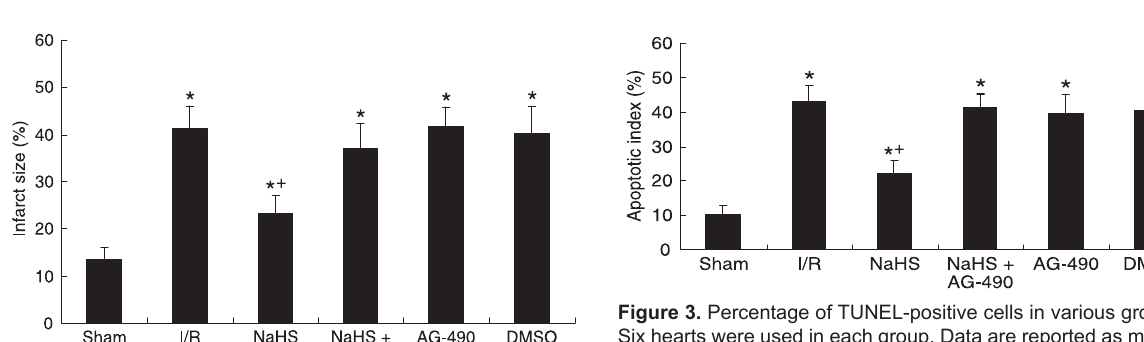
Figure 4. Western blot analysis. The phosphorylation status of STAT3 (86 kDa) ( A ), bcl-2 (26 kDa) and bax (21 kDa) ( B ) was analyzed by Western blot with specific phospho-STAT3 (Tyr705), bcl-2 and bax antibodies at the end of reperfusion. Four hearts were used in each group. Data are reported as means ± SD. *P < 0.05 vs Sham; + P < 0.05 vs I/R; ‡ P < 0.05 vs NaHS (one- way ANOVA). For abbreviations of groups, see legend to Figure